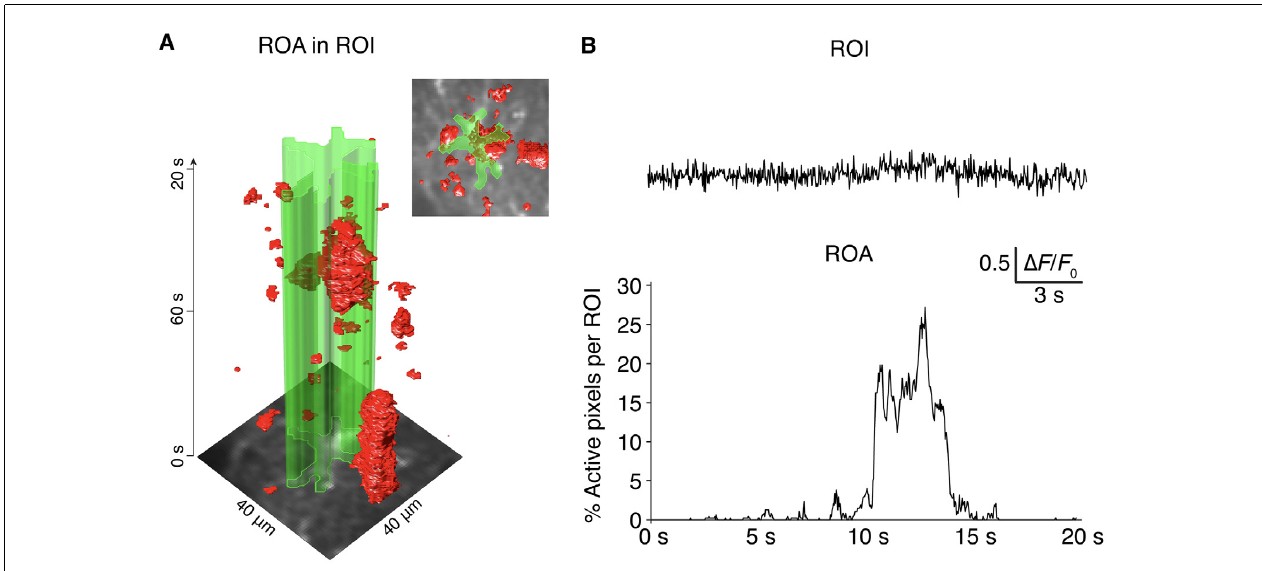
FIGURE 6 | ROA algorithm vs. ROI analyses. (A) The complex spatiotemporal distribution of astroglial Ca 2+ signals presented as an x-y-t volume rendering. The outline of an astrocyte (ROI) is presented in green. (B) The ROA algorithm is considerably more sensitive than a standard ROI-based analysis, as evident when comparing the percentage of active pixels detected with the ROA algorithm within the ROI defined in (A) , compared to the extracted mean fluorescence from the ROI defined in (A) where no signals would be detected with a standard peak detection algorithm.